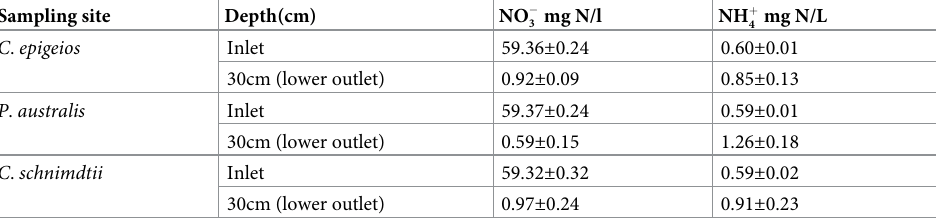
Table 2. Nitrate ( NO (cid:0) ) and ammonium ( NH þ ) concentrations measured at different depths (upper inlet (5cm 4 3 above soil-water surface) and lower outlet (30cm)) of the laboratory experiment soil columns. Results are in mean ± SE for the whole study period (30 day time